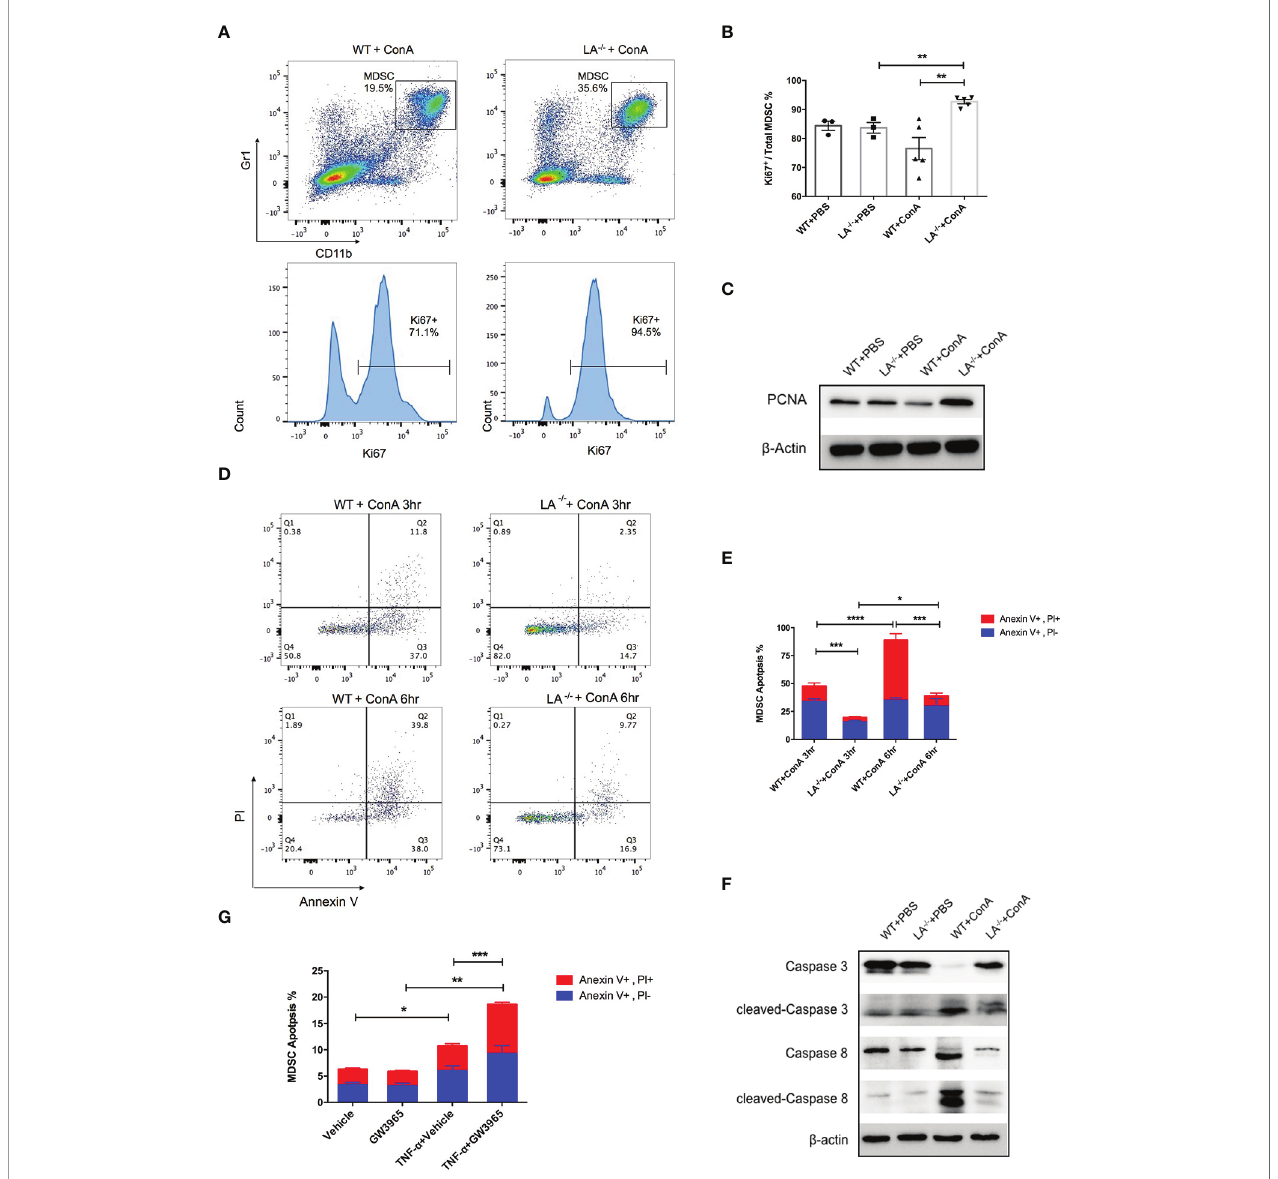
FIGURE 3 | Deletion of LXR a -favored proliferation and survival of MDSCs. (A) Representative fl ow cytometric images of ki67 expression in hepatic MDSCs in WT and LXR a − / − mice following an 18-h ConA treatment. (B) Statistic analyze of Ki67 + percentage in MDSCs in each group. (C) Expression of PCNA in MDSCs was measured by Western blot. (D, E) Hepatic MDSCs were gated and further analyzed for the staining of Annexin V and PI at the time of 3 and 6 h after ConA injection. Annexin V + , PI − cells were early apoptotic, while Annexin V + , PI + cells were regarded as late apoptotic. (F) MDSCs puri fi ed from WT and LXR a − / − mice were bulked and analyzed for the activation of caspase-3 and caspase-8 pathways by Western blot. (G) MDSCs isolated from WT and LXR a − / − mice were in vitro treated with or without 10 m M LXR agonist GW3965 for 24 h, and 20 ng/ml TNF- a was further added to induce cell apoptosis. All data are presented as mean ± SEM. * p > 0.05, ** p < 0.01, *** p < 0.001, and **** p <